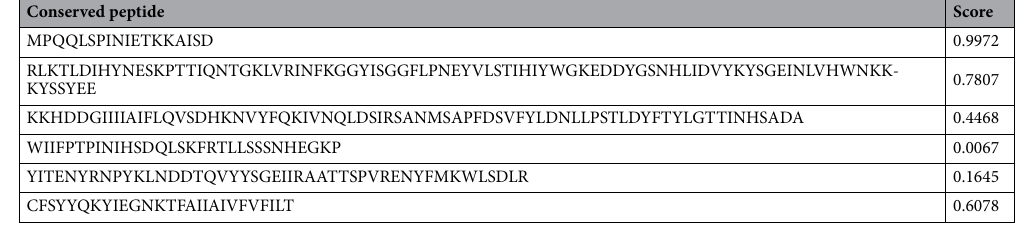
Table 1. Conserved regions of Cell surface binding